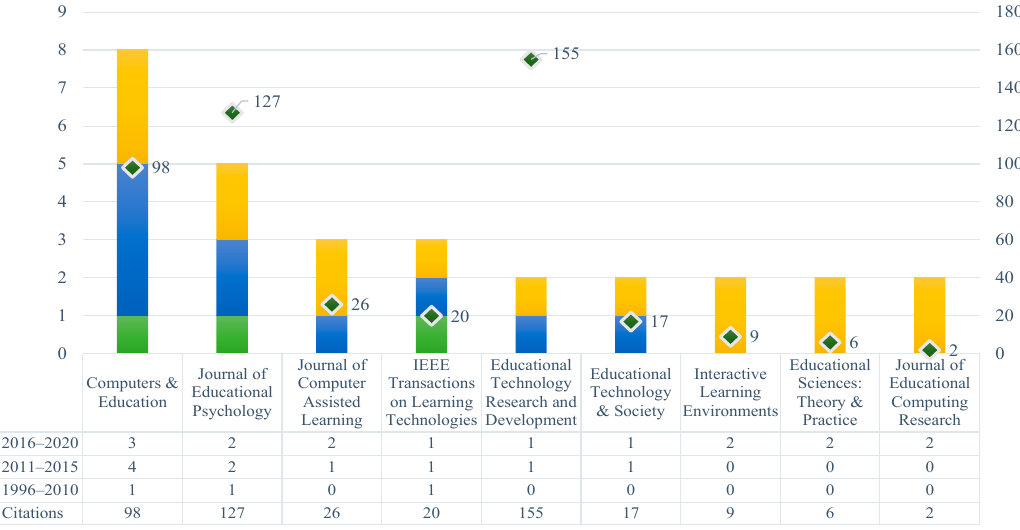
Figure 3. Published literature on AI in mathematics education from 1996 to 2020.